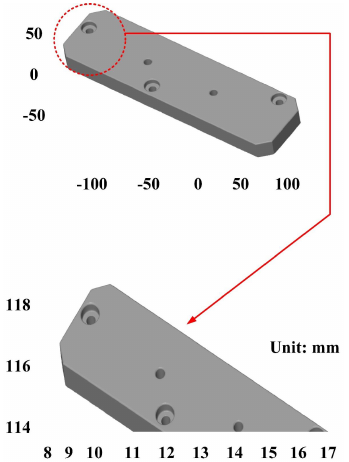
Figure 8. Measurement results of the cast part after CNC machining that was sprayed with a mixture of TiO 2 powder and ethanol before 3D optical measurement. Materials 2022 , 15 , 6139